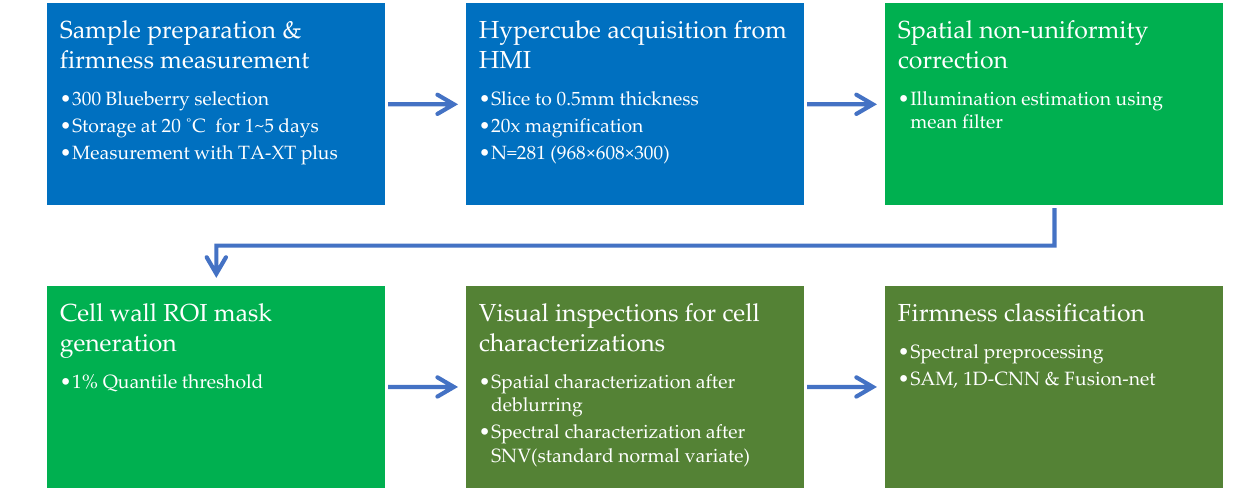
Figure 1. Summary pipeline of the blueberry firmness study.